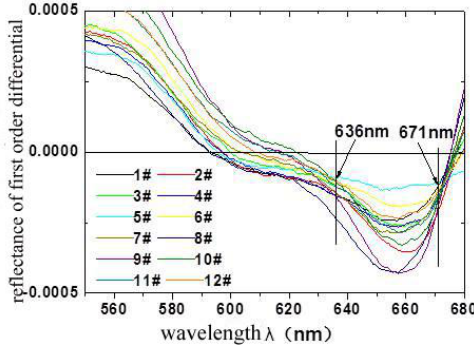
Figure 5. reflectance of first order differential amplifier in 560-674nm